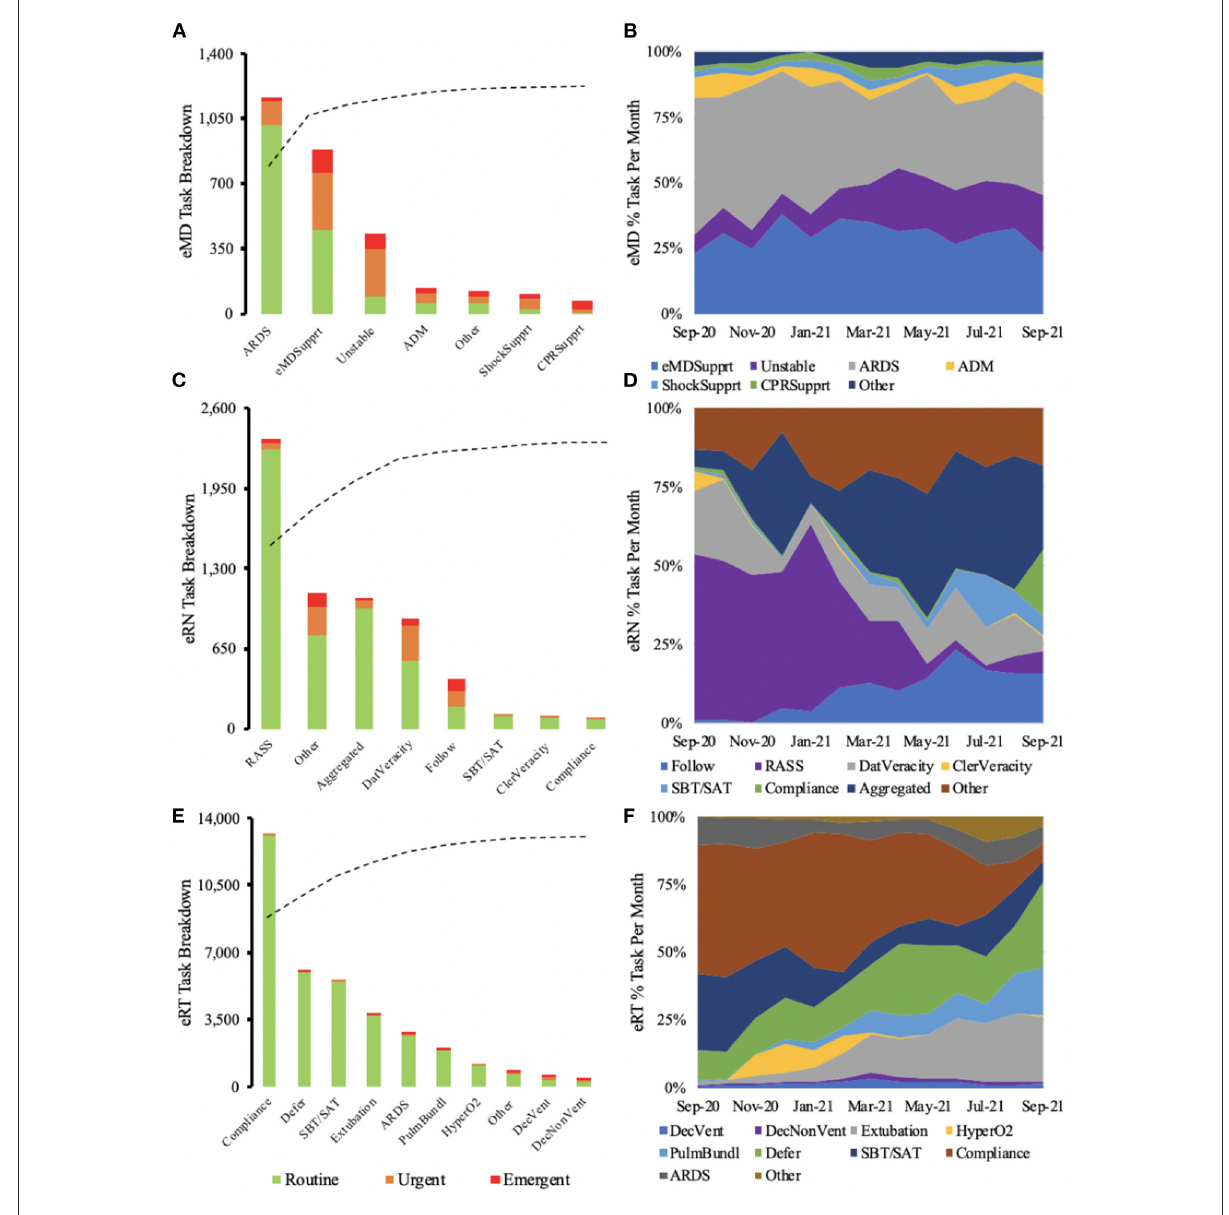
FIGURE1 Majority of routine eMD tasks were associated with ARDS, while the majority of urgent and emergent interactions required eMD support (A) . Over the year, eMD tasks remained similar, with a slight increase in tasks involving unstable patients toward the end of the year (B) . eRN routine tasks were dominated by RASS (C) , but when observed over the year, RASS saw a steep decline toward the end of the year (D) . The majority of eRT routine tasks consisted of compliance (E) . As time progressed, there was a decrease in compliance and an increase in task deference (F)